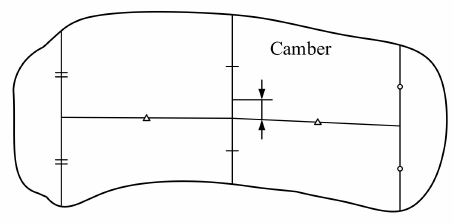
Figure 4. Sketch for determining the sickness of the